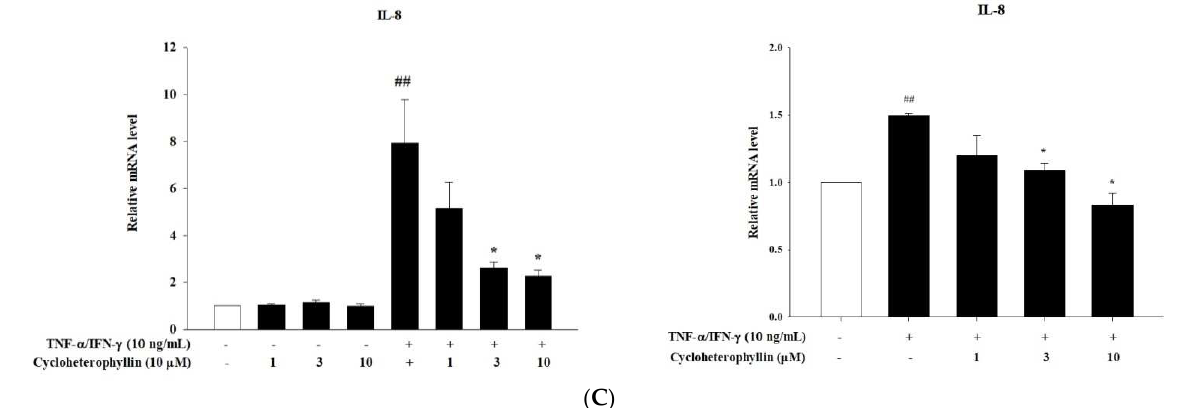
Figure 2. The anti-inflammatory potential of cycloheterophyllin in the TNF-α/IFN-γ-induced inflammatory response in HaCaT cells (left panel) and human epidermal keratinocytes (right panel). HaCaT cells were pretreated with different concentrations of cycloheterophyllin (1, 3, and 10 μM) for 1 h, then cells were treated with TNF-α/IFN-γ (10 ng/mL) for 1 h. Total RNA was isolated and mRNA expression levels of ( A ) IL-1β, ( B ) IL-6, and ( C ) IL-8 were determined using qPCR. Values represent mean ± SEM from three independent experiments. ## p < 0.01 compared to untreated conditions; * p < 0.05 and ** p < 0.01 compared to TNF-α/IFN-γ treated conditions.